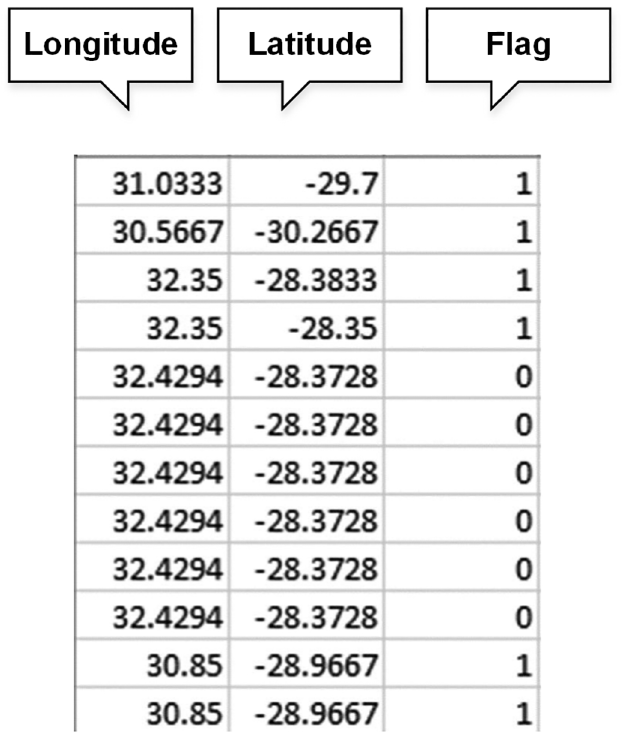
Fig 4. Result of cross-checking (0 indicates that geographic coordinates may be wrong, 1 indicates that geographic coordinates are correct).